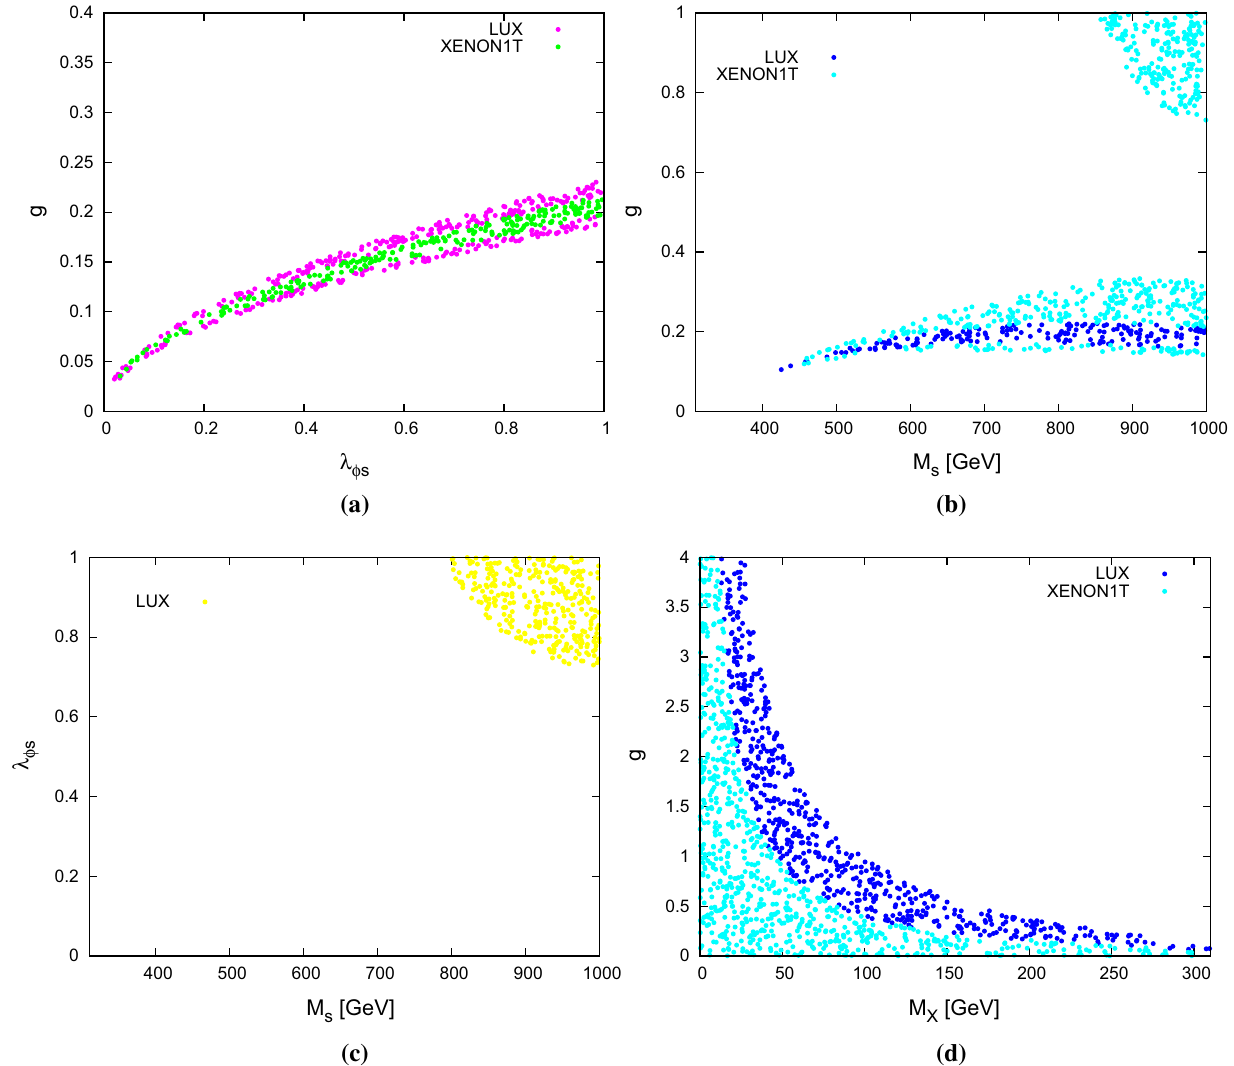
Fig. 6 a – c Depict the ranges of parameter space in the g , λ φ s and M s planes for scalar DM and d depicts the allowed regions in g and M χ for fermionic DM, which are consistent with experimental measurements